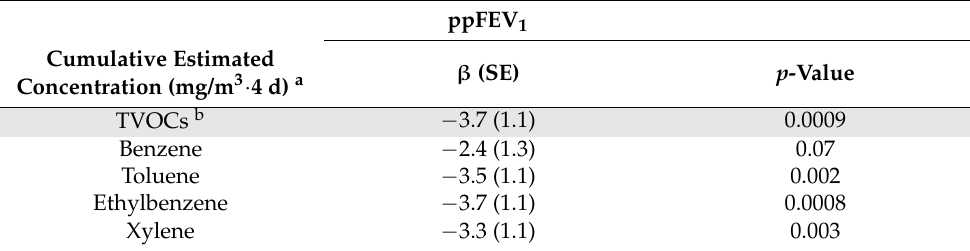
Table 4. Longitudinal associations between exposure to VOCs and loss of lung function up to 5 years after the very high environmental exposure to VOCs from the Hebei Spirit oil spill (n = 224). ppFEV 1 Cumulative Estimated Concentration (mg/m 3 · 4 d)